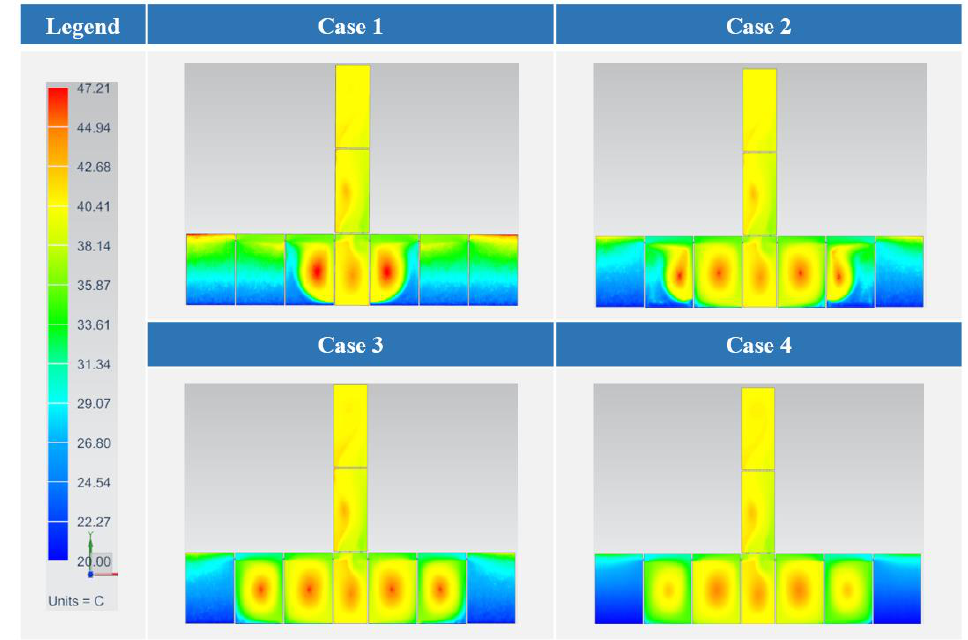
Figure 8. Velocity distribution in an air-type BIPVT collector.